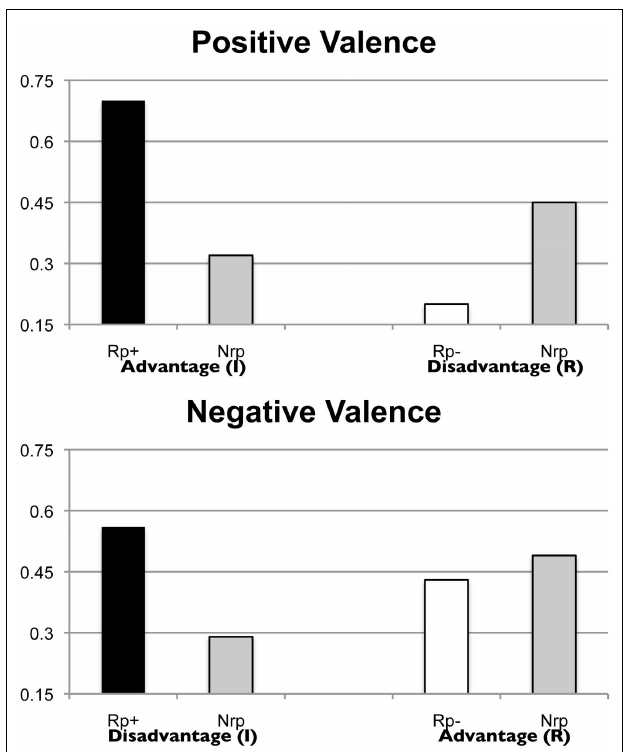
FIGURE 4 | Recall proportion for Rp + /Nrp and Rp − /Nrp items in Experiment 2, for the PositiveValence Condition (irrelevant advantages received selective practice) (on the top), and the NegativeValence Condition (irrelevant disadvantages received selective practice) (on the bottom) . R stands for relevant, and I stands for irrelevant. In the Positive Valence Condition, we compared Rp + items (irrelevant advantages) with Nrp advantage items, and Rp − items (irrelevant disadvantages) with Nrp disadvantage items. Similarly, in the NegativeValence Condition, we compared Rp + items (irrelevant disadvantages) with Nrp disadvantage items, and Rp − items (irrelevant advantages) with Nrp advantage